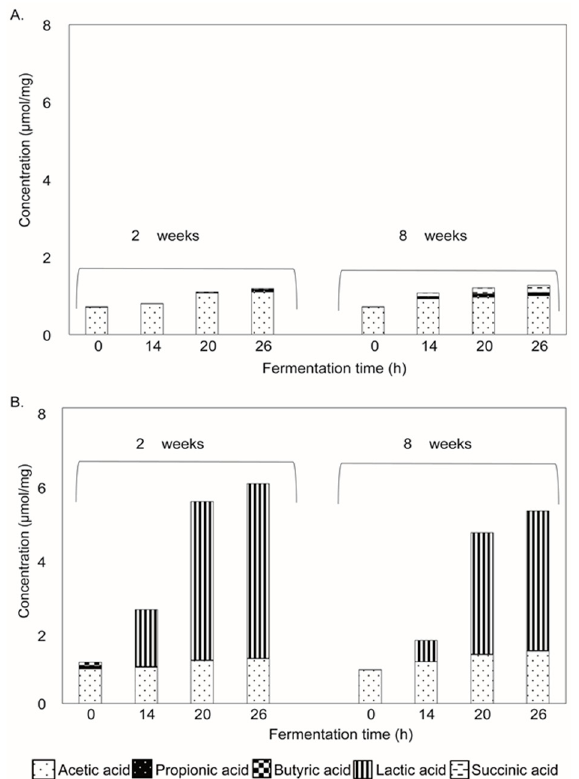
Figure 4. Production of SCFAs, lactic acid and succinic acid upon fermentation of media supplemented with native oat β‐ glucan ( A ) and enzyme ‐ treated oat β‐ glucan ( B ) using pooled fecal inoculum of 2 ‐ and 8 ‐ week ‐ old infants.